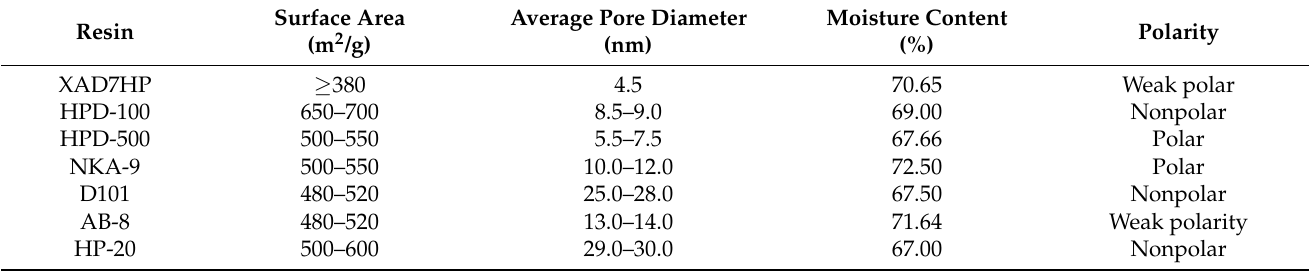
Table 1. Physical parameters and moisture contents of the macroporous